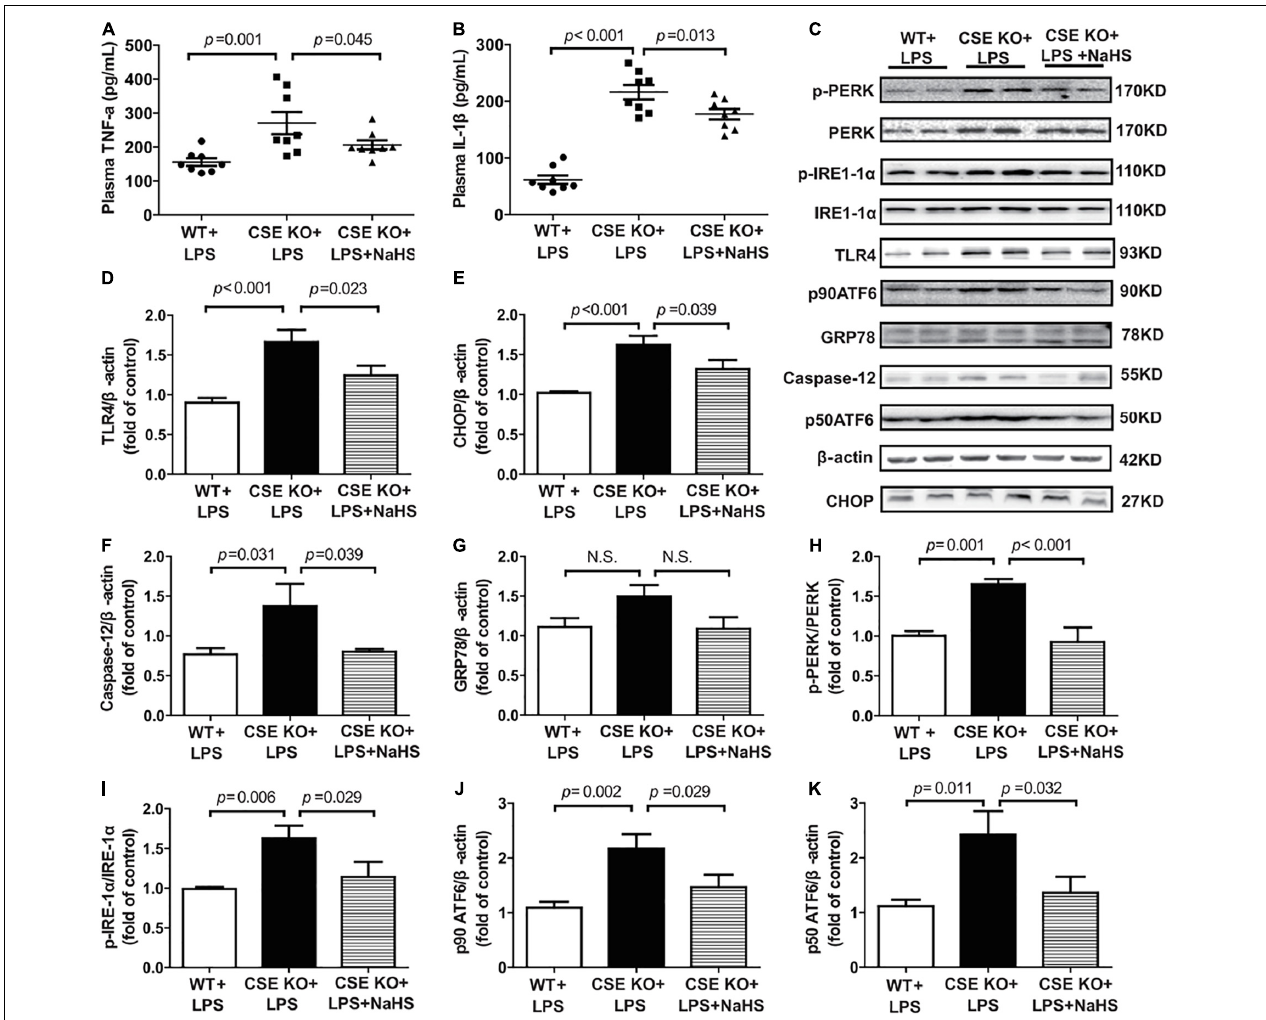
FIGURE 6 | H 2 S inhibited inflammation and ERS in CSE KO mice: (A) TNF- α levels in the plasma. (B) IL-1 β levels in the plasma. (C–K) Representative Western blots and quantitative analysis for TLR4, CHOP, Caspase-12, GRP78, p-PERK/PERK, p-IRE1/IRE1, p90 ATF6, and p50 ATF6 protein expression in heart tissues. β -actin was used as the internal control. n = 8 in every group. Results are means ± SEM. p < 0.05 was considered